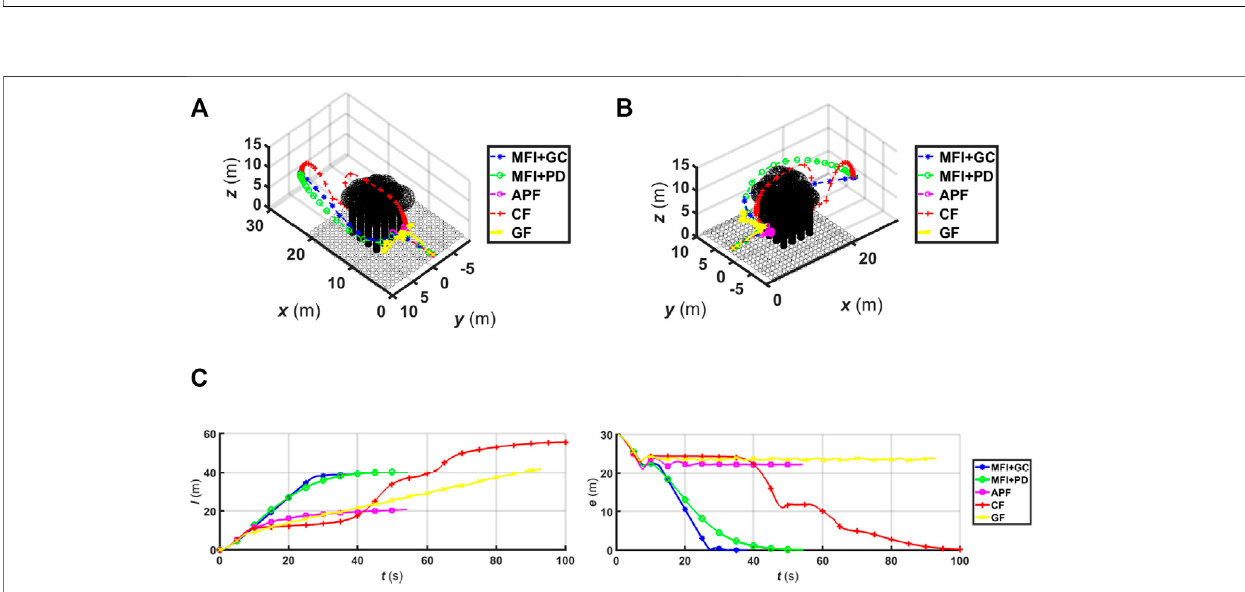
FIGURE8| Therobot ’ strajectorydrawnindashed linesfromtwodifferentperspectives( (A , B) ).Theenvironmentconsistsofaforest-likeenvironment. (C) Theplot of the covered trajectory l(t) and the positional error e(t) as function of time for 3D forest environments.